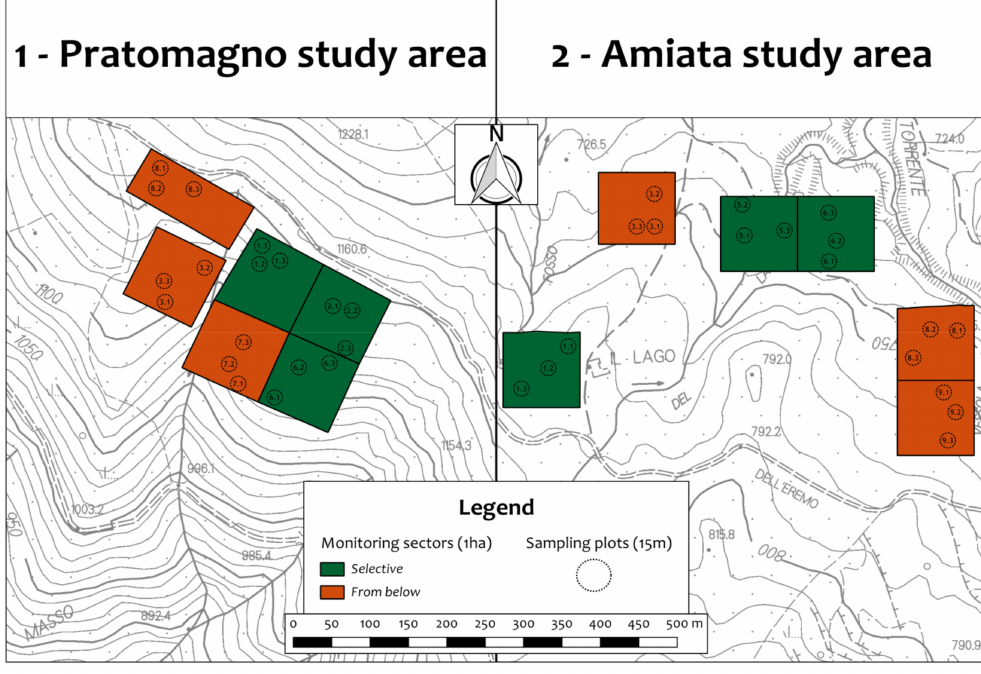
Figure 2. Spatial distribution of monitoring sectors and sampling plots in both of the study areas. The different thinning systems applied are marked with different